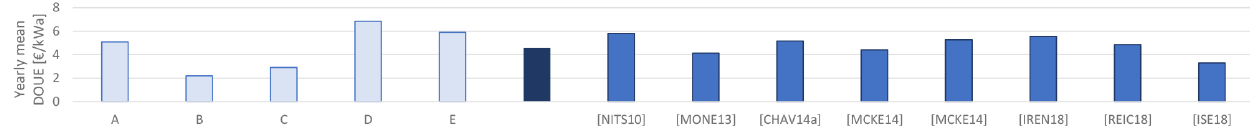
Figure 4. Scaled meta-study about yearly mean DUOE and model results (Nitsch et al., 2010; Mone et al., 2013; Chaviaropoulos et al., 2014; McKenna et al., 2014; IRENA, 2018; Reichenberg et al., 2018; ISE Fraunhofer, 2018). Table 3. Considered drivetrain concept characteristics and their market share (Hernandez et al., 2017). Concept A B C Suspension system Moment Moment Trunnion Three-point Four-point Gearbox Two-stage Three-stage Three-stage